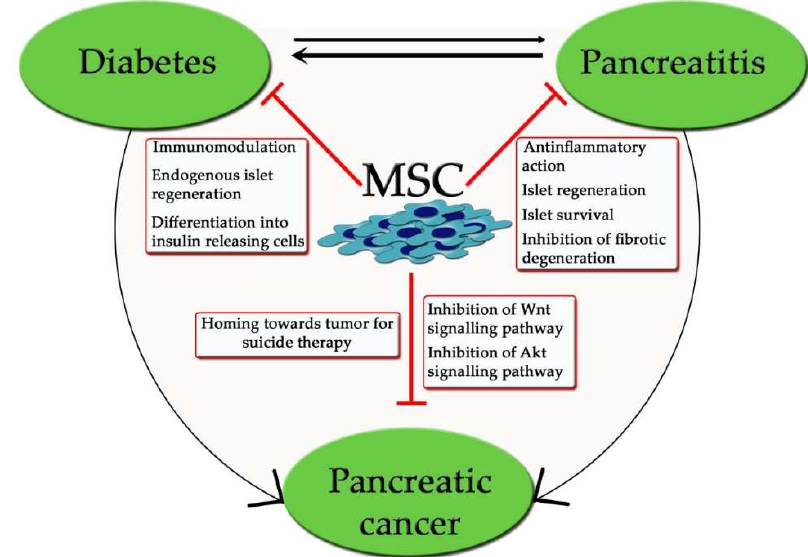
Figure 3. Overview of the relationships among pancreatic disorders and of MSC positive mechanisms.